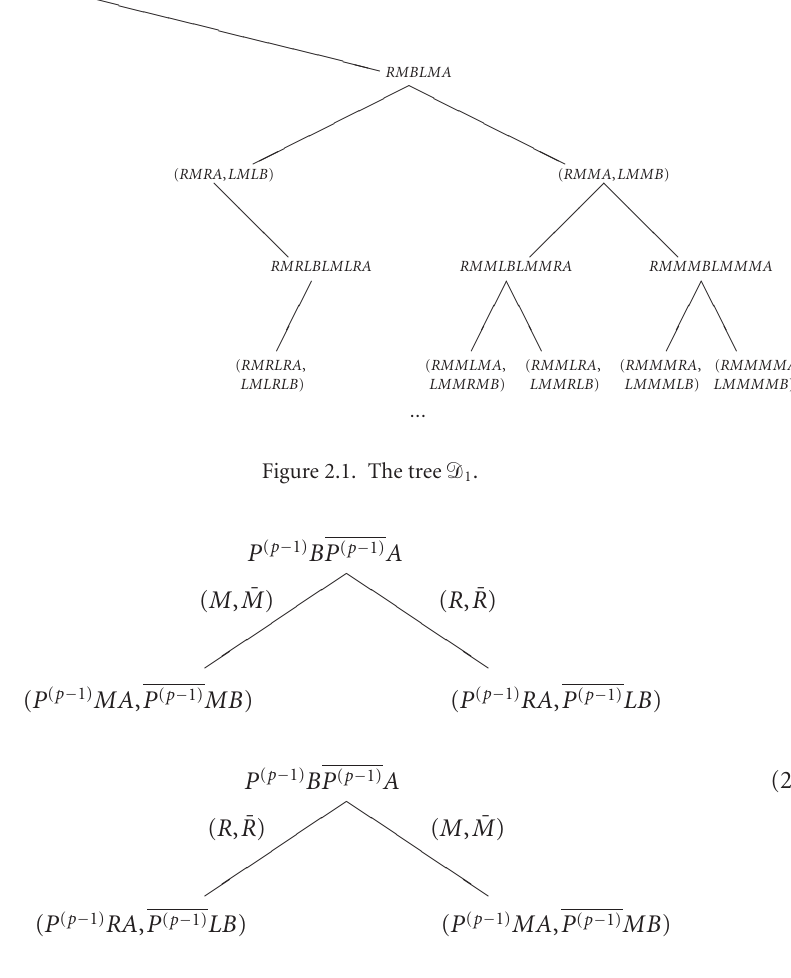
Figure 2.1. The tree (cid:2) 1